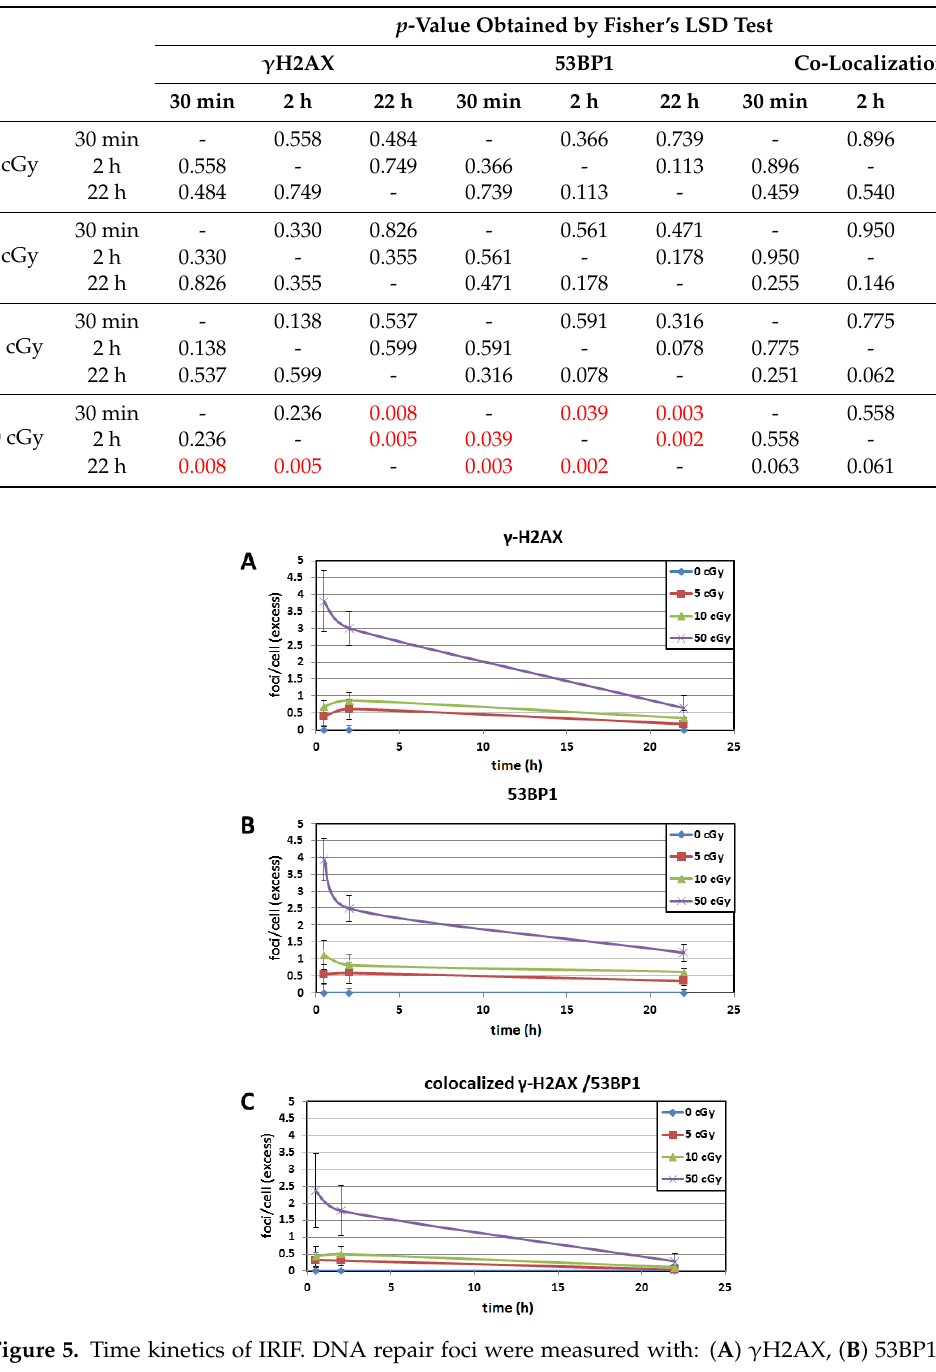
Table 4. Comparison of γ H2AX, 53BP1 and co-localized γ H2AX / 53BP1 foci between post-irradiation time points. Statistically significant values are marked in red.